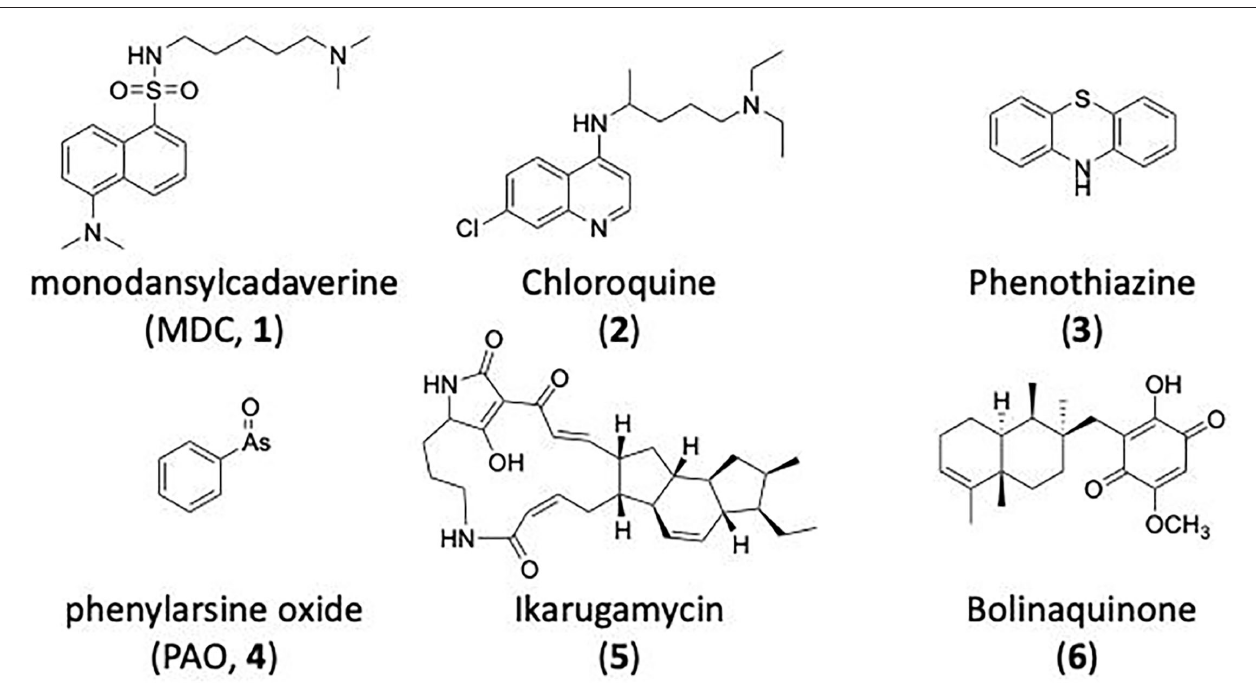
FIGURE 7 | Structures of small molecules CME inhibitors; monodansylcadaverine (MDC, 1 ), chloroquine ( 2 ), phenothiazine ( 3 ), Phenylarsine oxide (PAO, 4 ), Ikarugamycin ( 5 ), and bolinaquinone ( 6